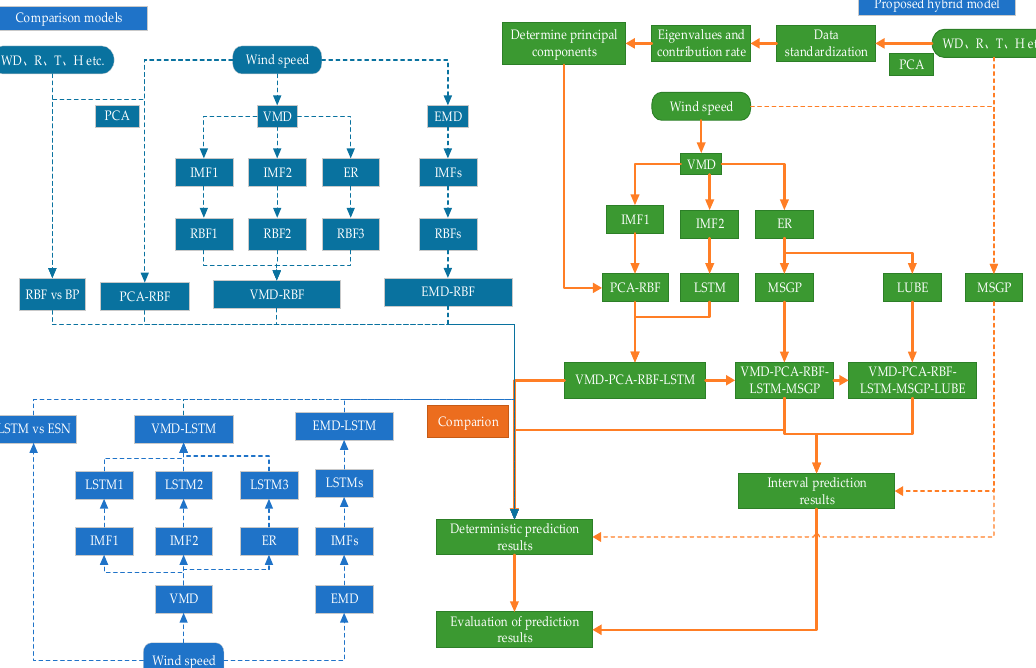
Figure 10. The flow chart of the proposed wind speed prediction (WSP) model and comparison models.